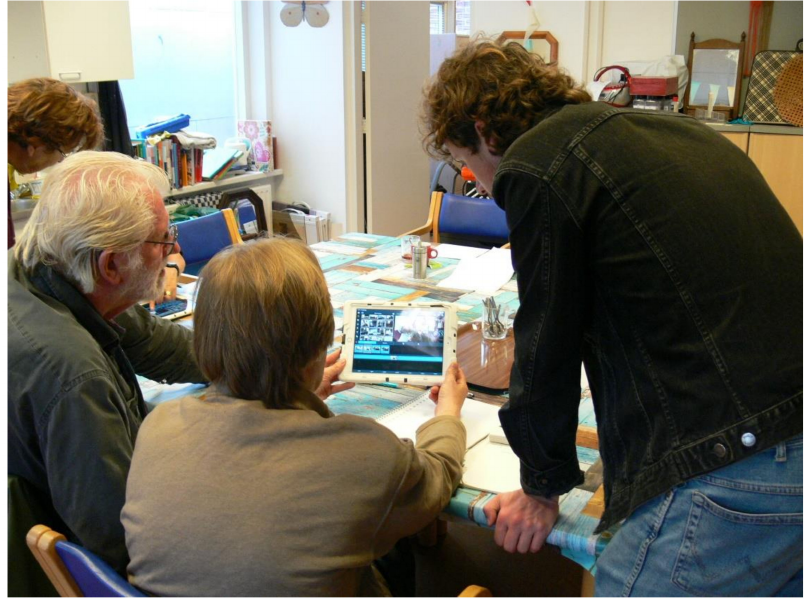
Figure 3. Editing the video fragments in